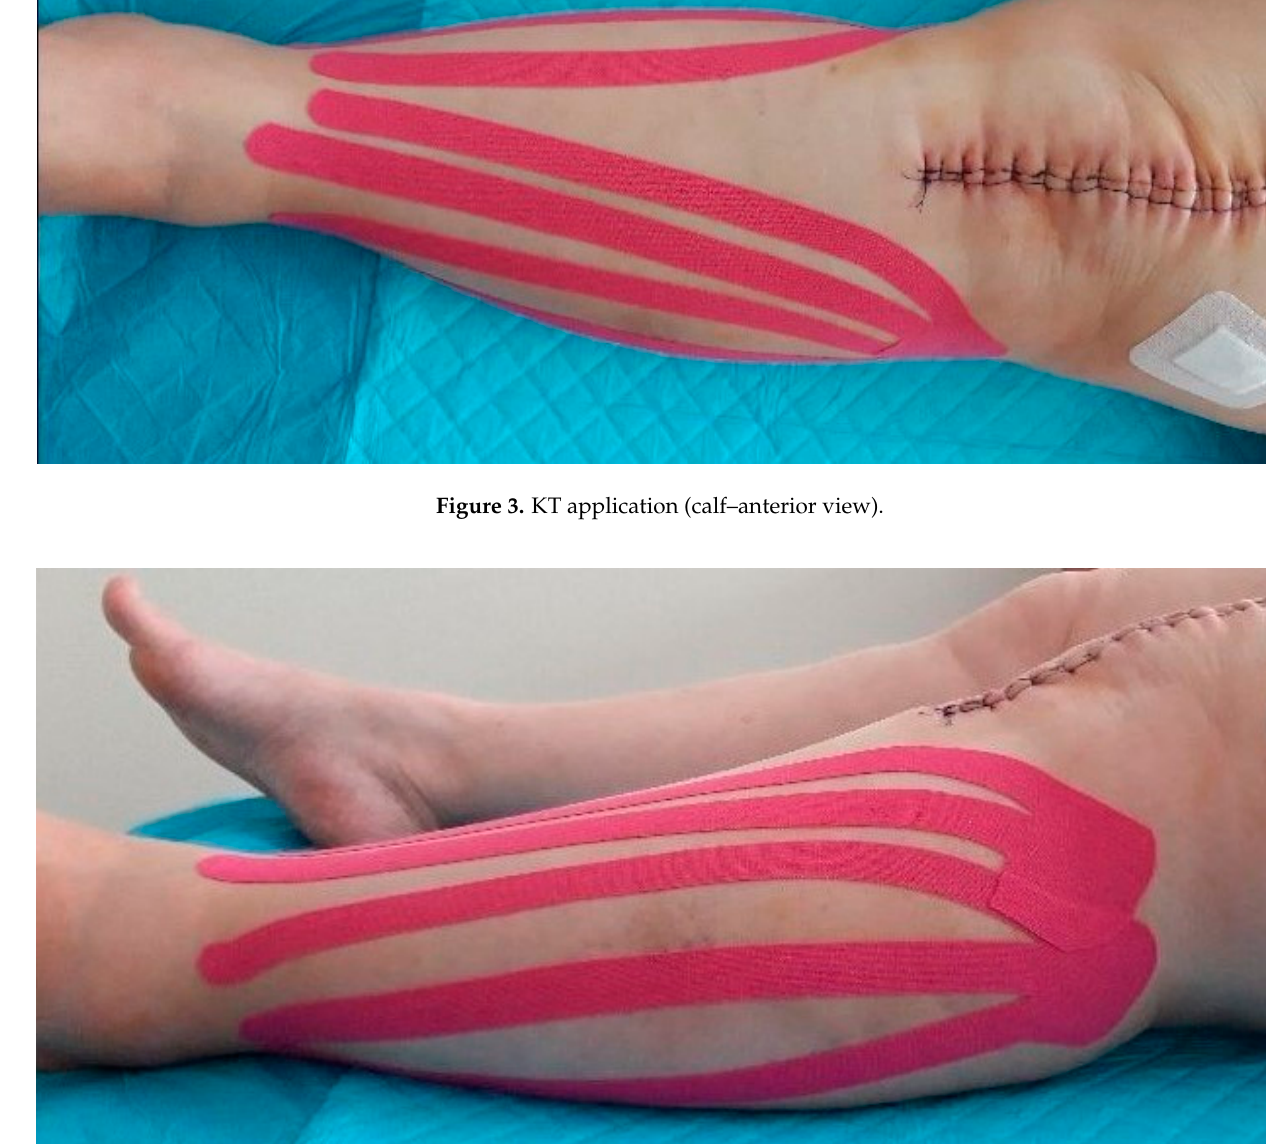
Figure 4. KT application (calf–lateral view).